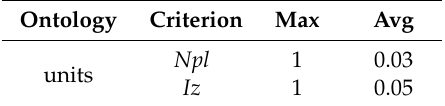
Table 1. Development tuples of subgraphs of the “units” ontology.